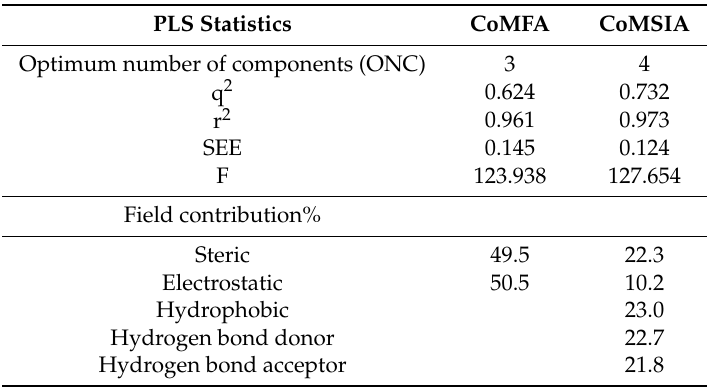
Table 3. Statistical results of the CoMFA/CoMSIA